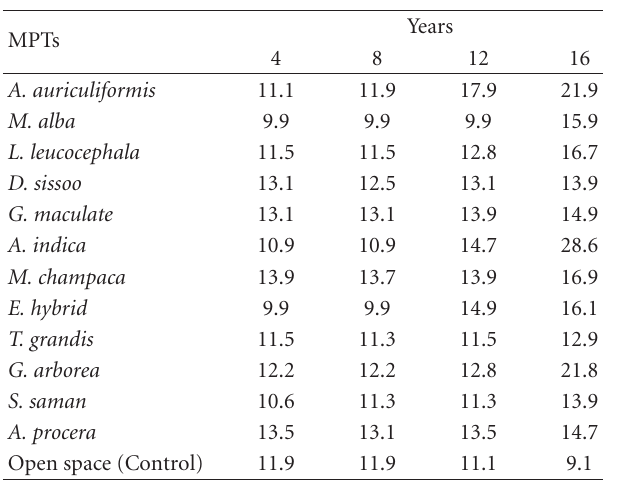
Table 8: Changes in SOC (Mg hm − 2 ) over the years under various MPTs in humid tropics.